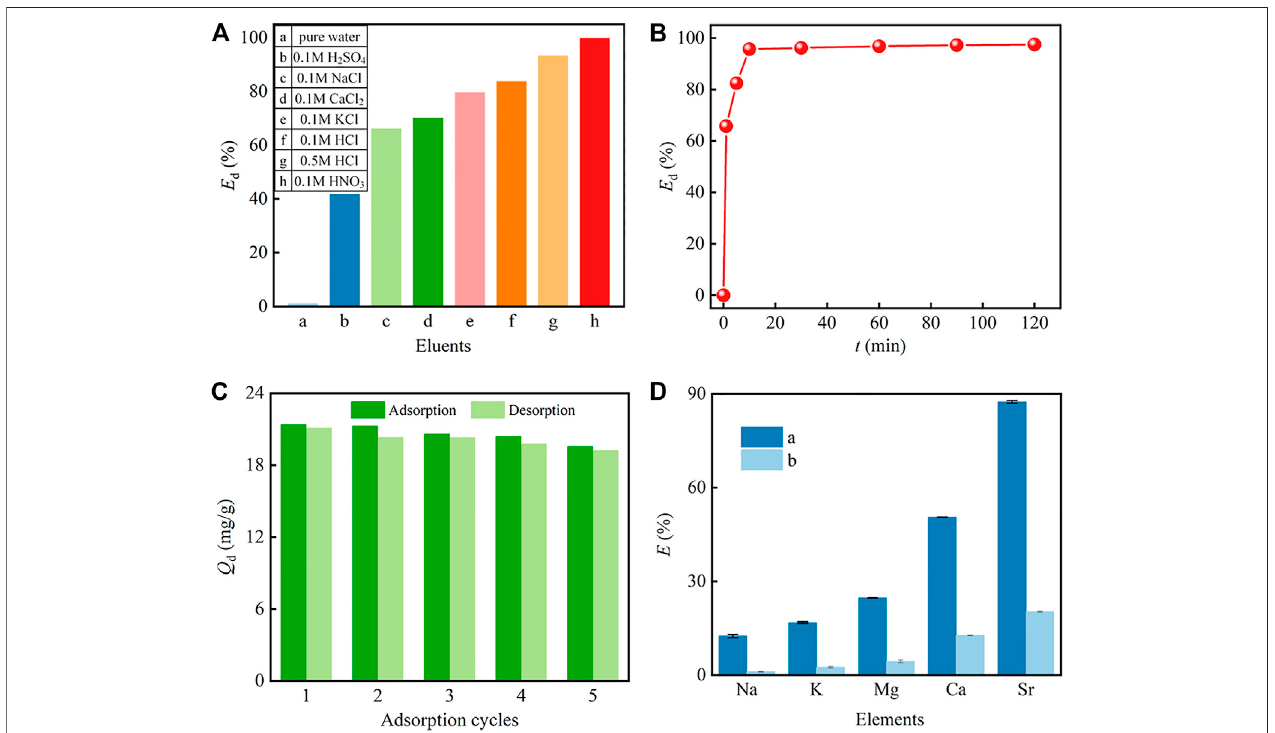
FIGURE7|(A) Desorptionef fi ciencyofSr(II)byvariouseluents, (B) kinetisstudyofthedesorptionprocess(Co:50 ppm,medium:0.1 MHNO 3 solution, m / v :2 g/L, T : 298 K, r : 120 rpm), (C) the reusability of PMBN3 ( C o : 50 ppm, m / v : 2 g/L, T : 298 K, t : 1 h, r :120 rpm), (D) single-component and competitive adsorption ( C M : 50